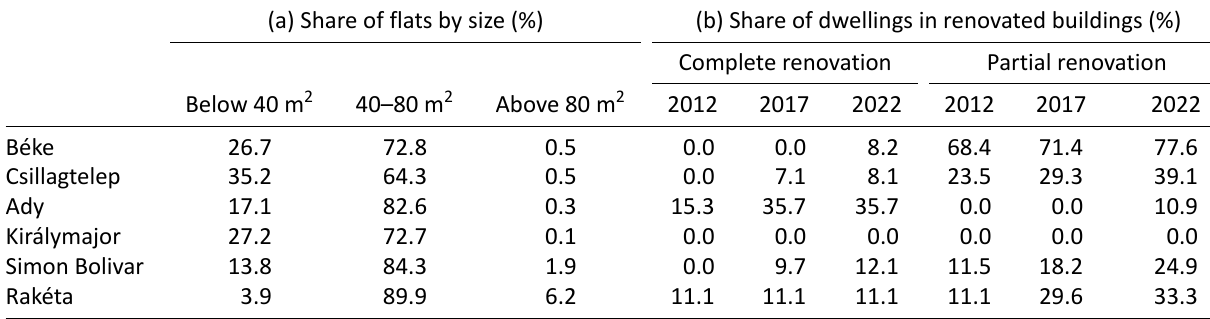
Table 3. Characteristics of HEs in Csepel.